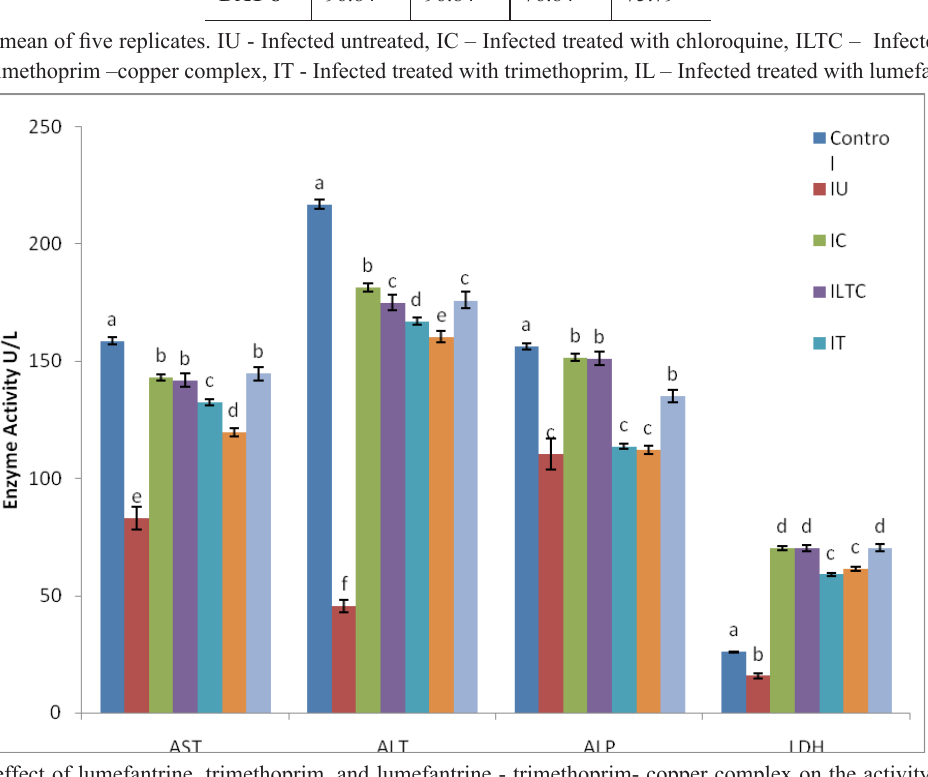
Figure 1: The effect of lumefantrine, trimethoprim, and lumefantrine - trimethoprim- copper complex on the activity of AST, ALT, ALP and LDH in the liver of P. berghei NK-65 infected mice. Values are mean of 5 replicates ± SEM. Bars with different superscript are significantly (p < 0.05)